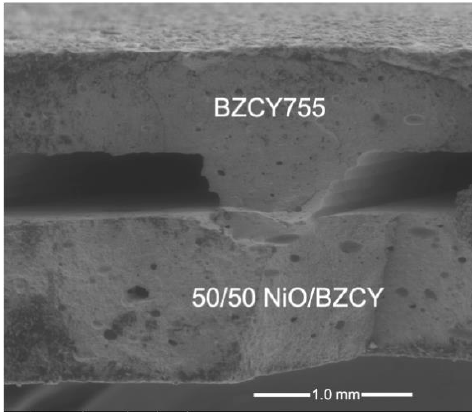
Figure 9. Secondary electron micrograph of laminated microstructure of a channelized substrate (unreduced) in cross-section.